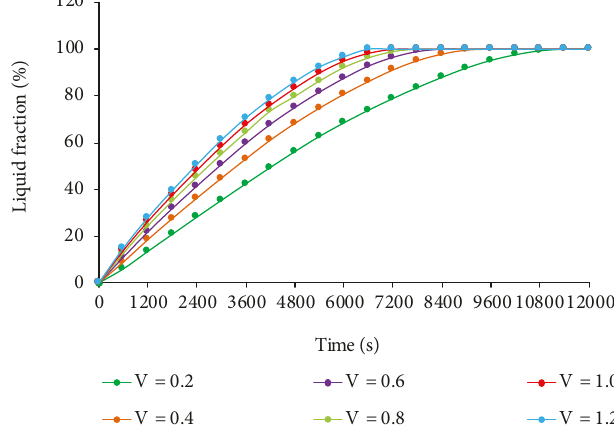
Figure 9: E ff ects of inlet velocity of HTF on liquid fraction.